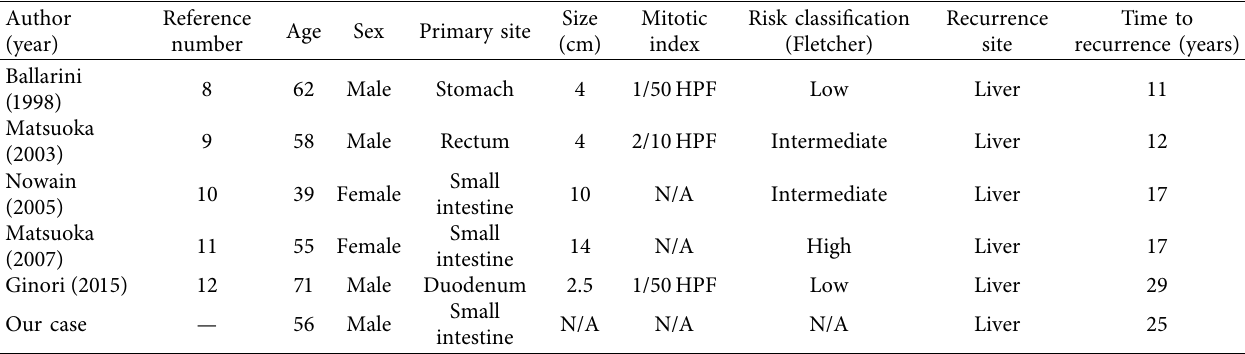
Figure 9: Lung findings at autopsy. (a) Macroscopic findings did not indicate a clear tumor in the lungs (x100). (b, c) Microscopically, multiple small lung metastases of GIST were observed in all lung lobes (arrow) (x200, Hematoxylin-Eosin stain). Table 1: Reported cases of GIST recurrence occurring later than 10 years after